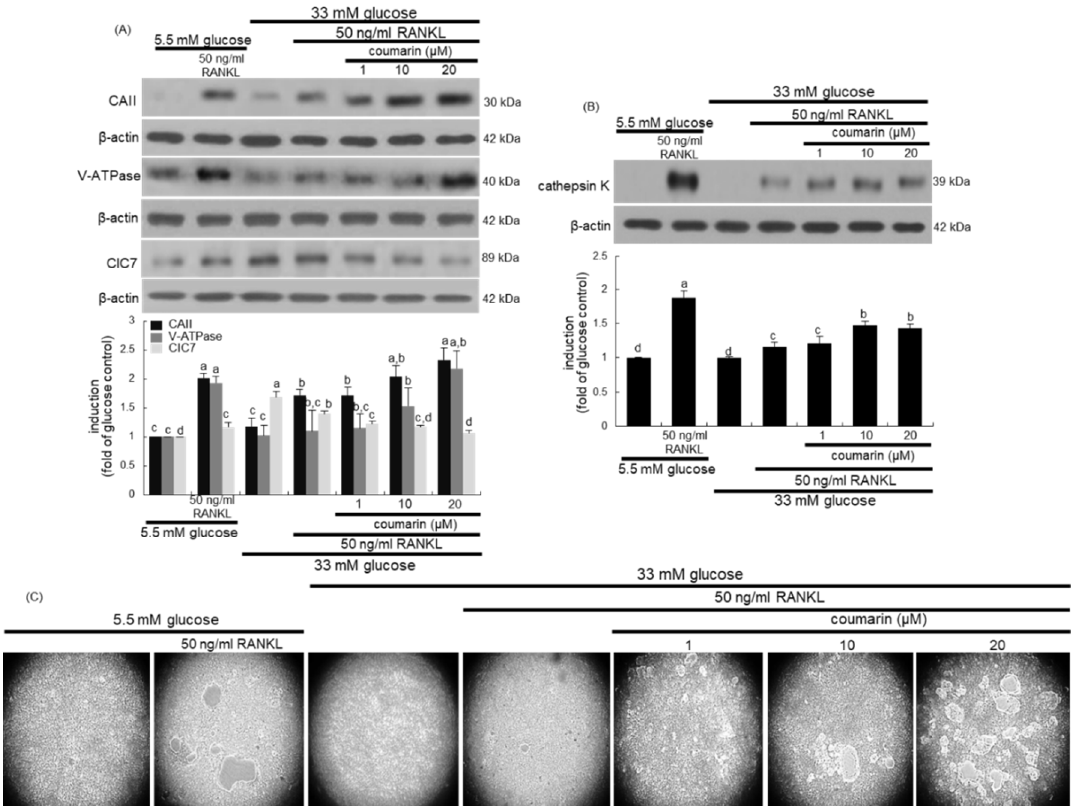
Figure 3. Western blot data showing the effects of coumarin on the induction of carbonic